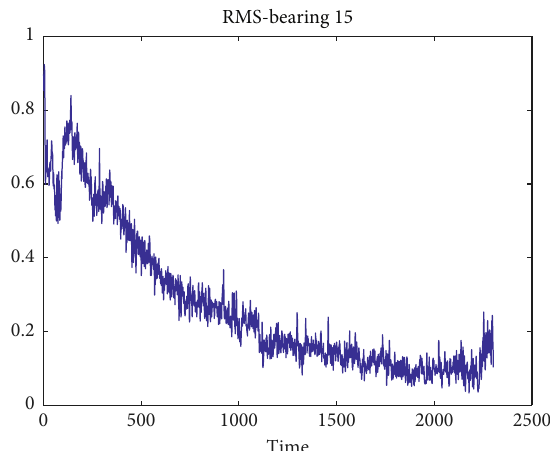
Figure 17: RMS for bearing 15 under various conditions such as “Normal,” “Slight,” and